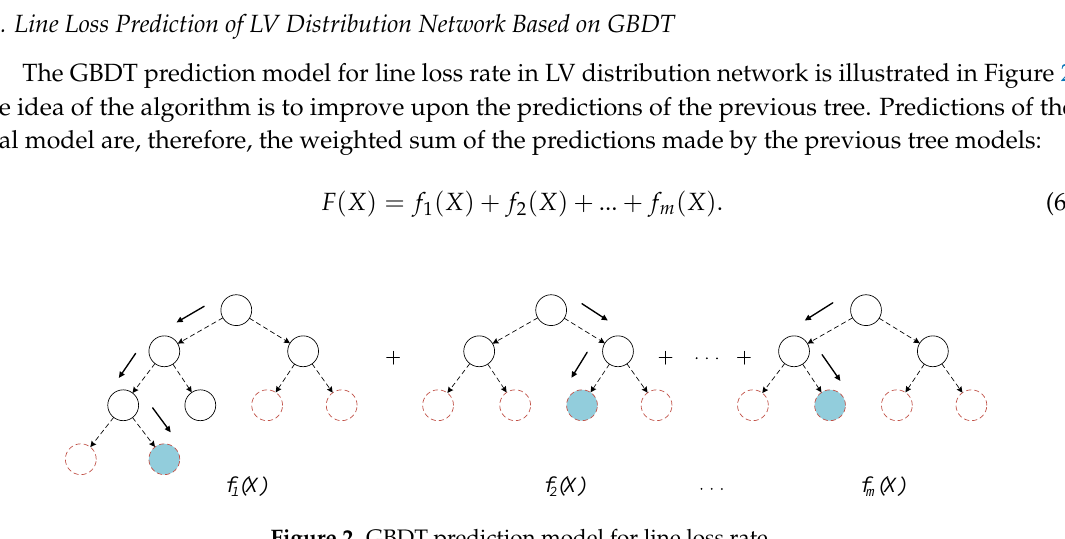
Figure 2. GBDT prediction model for line loss